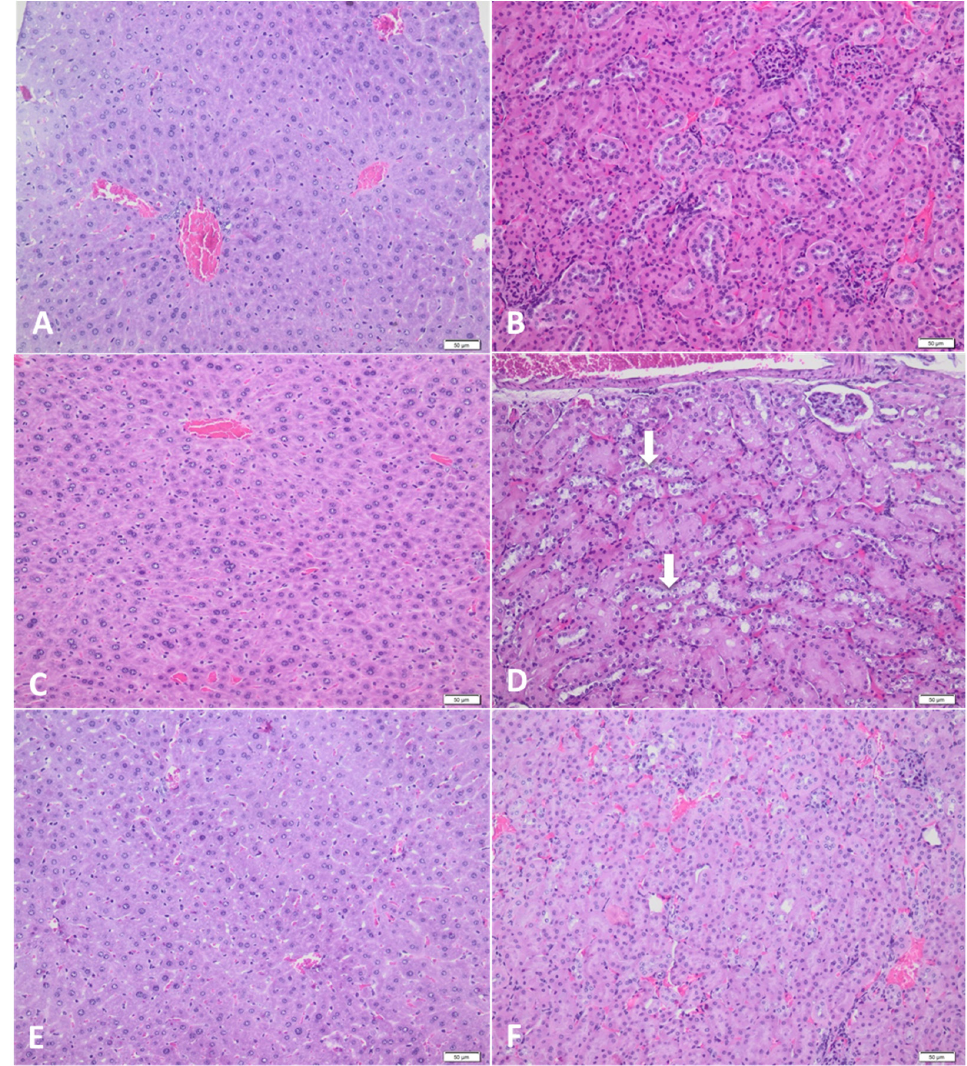
Figure 3. Histological findings of the liver and kidney from experimental Swiss mice. ( A , B ) Normal features of liver and kidney in the control group; ( C ) Normal hepatic parenchyma found in group III—1 mL of sodium glutamate; ( D ) Mild to moderate and multifocal vacuolar degeneration of the proximal convoluted tubular epithelium (arrows) in group III—1 mL of sodium glutamate; ( E , F ) No histological changes of the liver and kidney are present in the individuals of group IV—1 mL of sodium glutamate + 1 mL of spirulina; hematoxylin–eosin (H&E) stain.